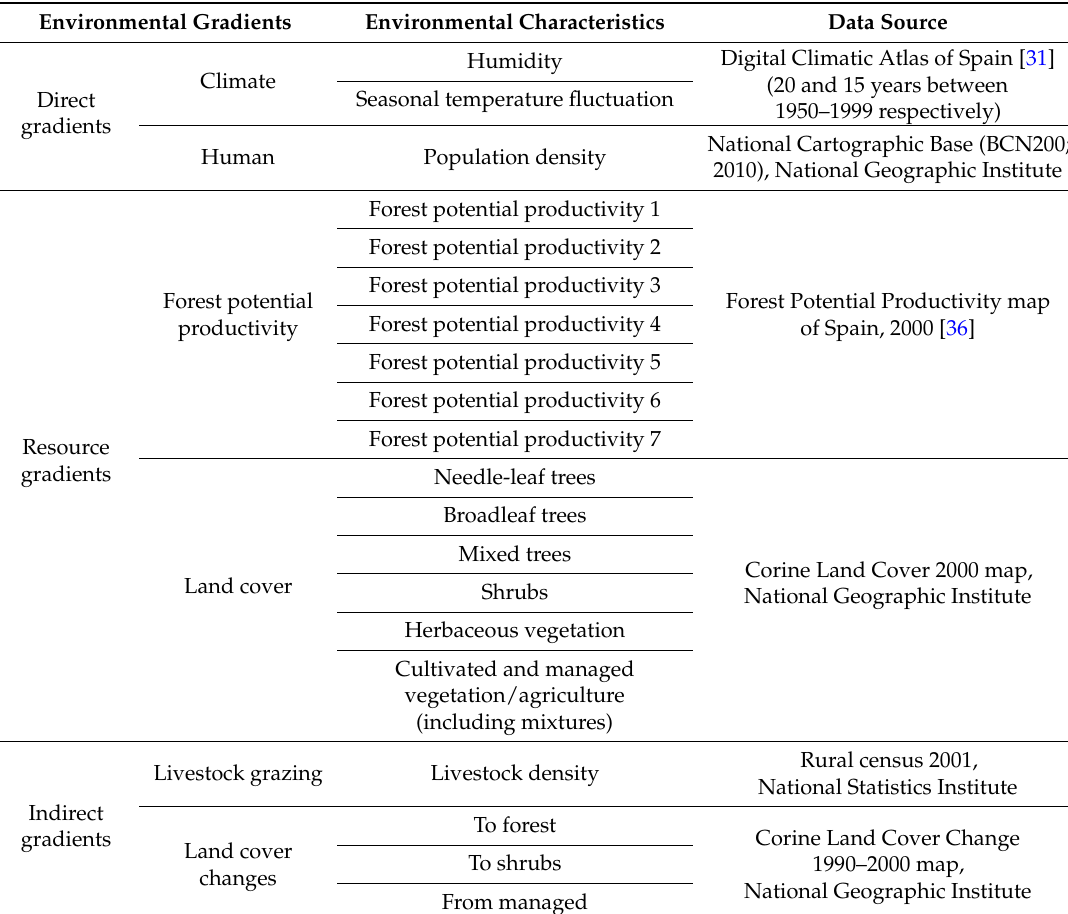
Table 2. Environmental gradients and characteristics data used in this